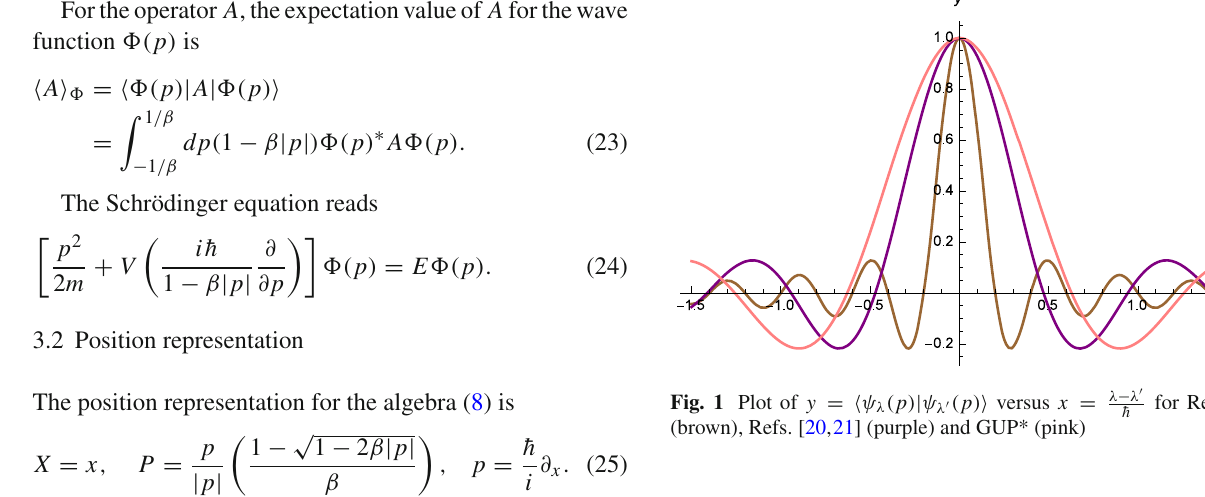
Ref. [14] (brown), Refs. [20,21] (purple) and GUP*